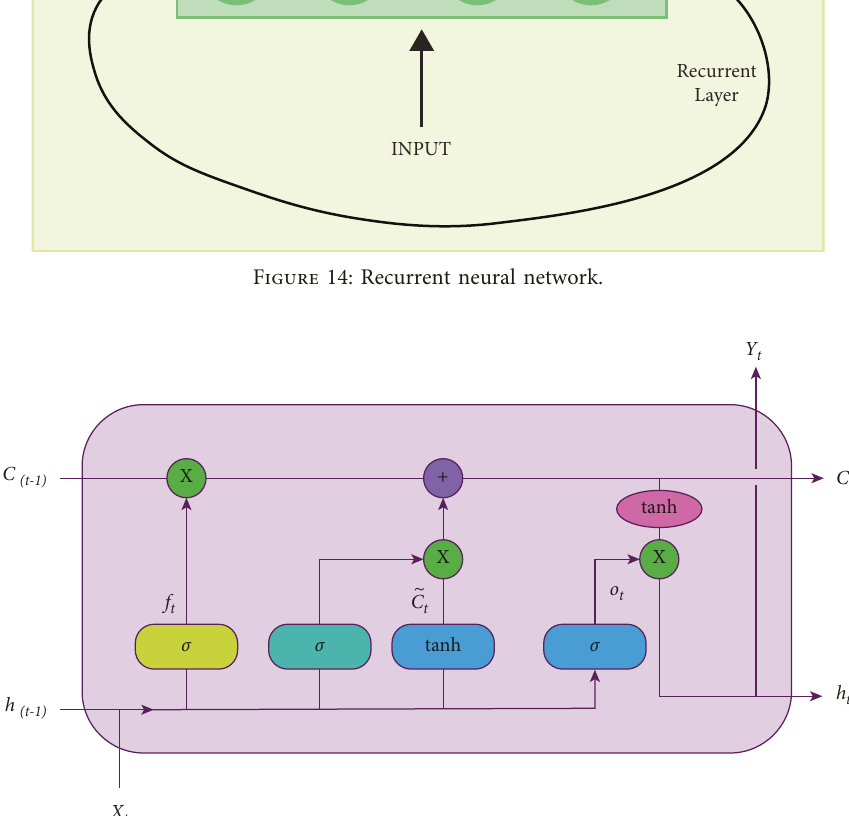
Figure 15: An LSTM